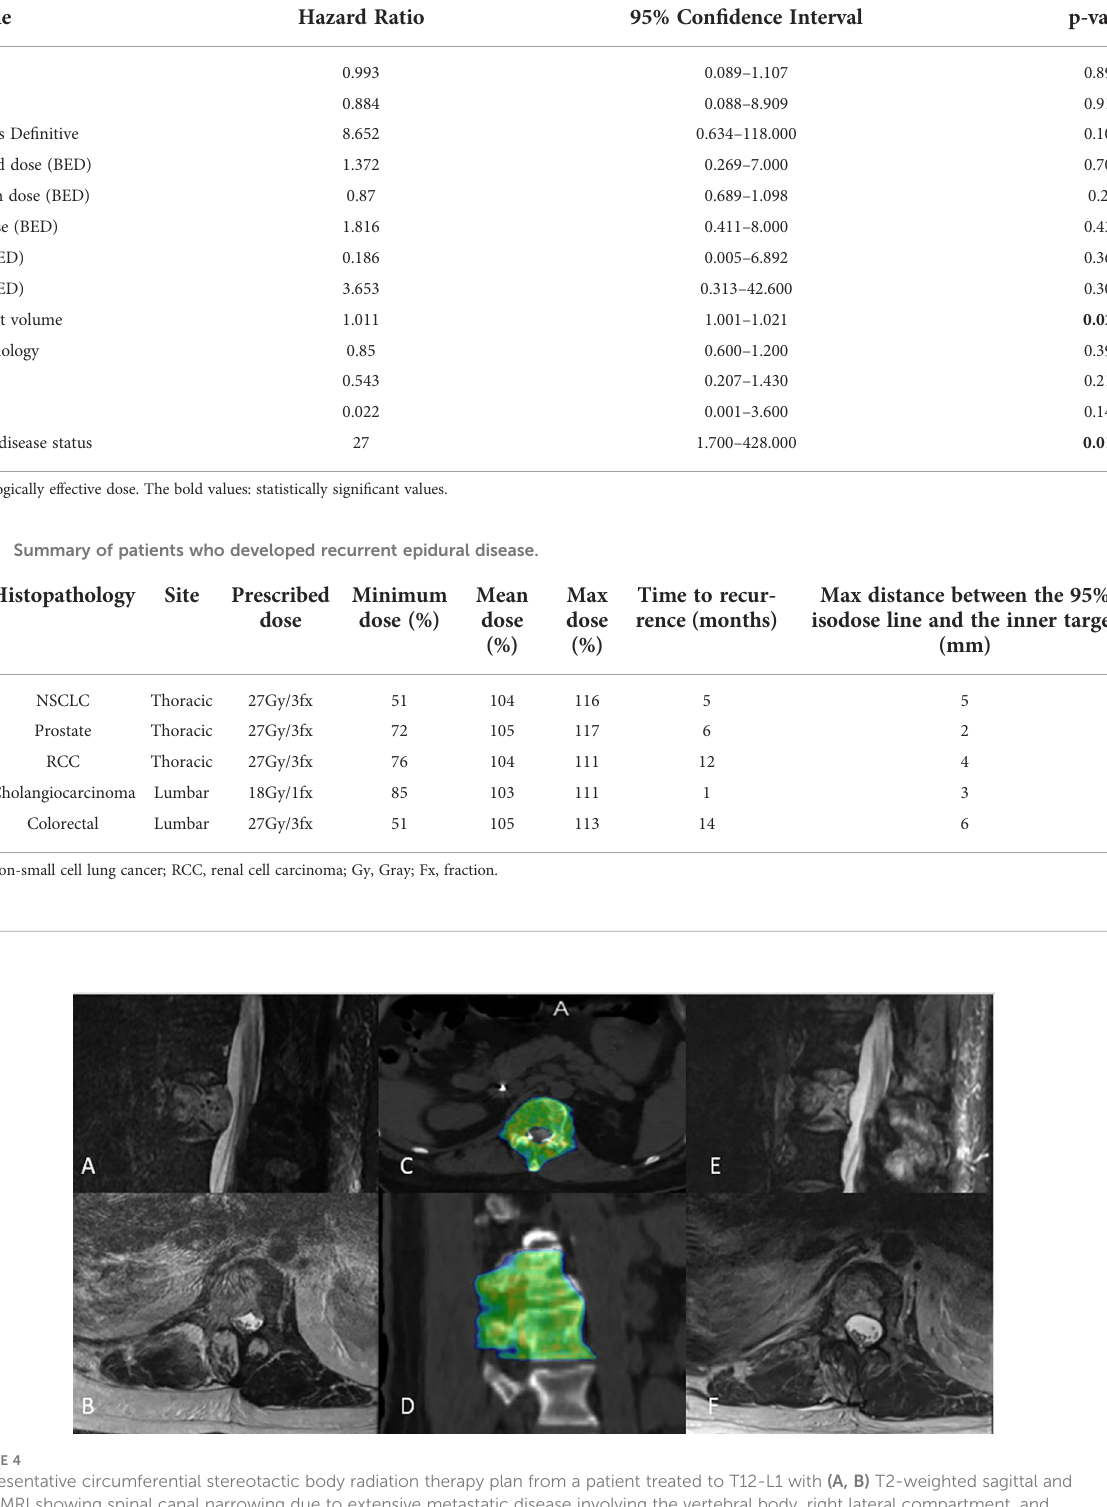
TABLE 3 Multivariate analysis examining for variables associated with increased likelihood of local failure in patients with ≥ 3 contiguous treated levels using a proportional hazards model.